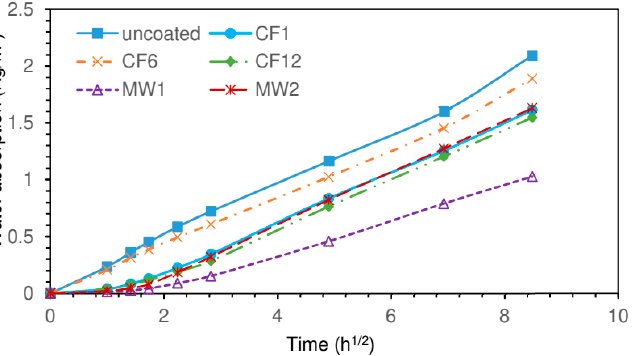
Figure 5. Water absorption of uncoated wood and coated wood (CF1, CF6, CF12, MW1 and